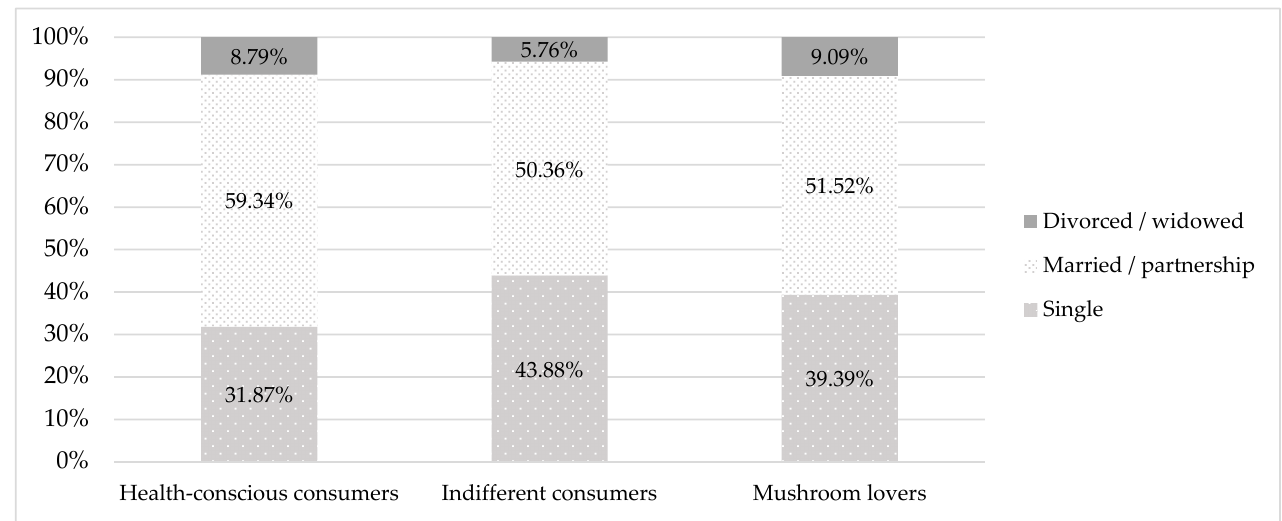
Figure 7. Distribution of family status within clusters generated based on level of consciousness in mushroom consump- tion.